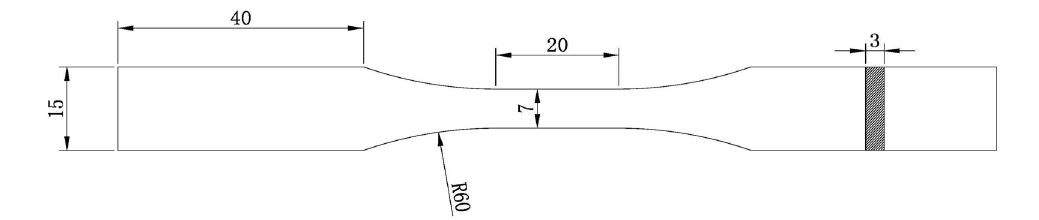
Figure 1: Size of the specimen (unit: mm).